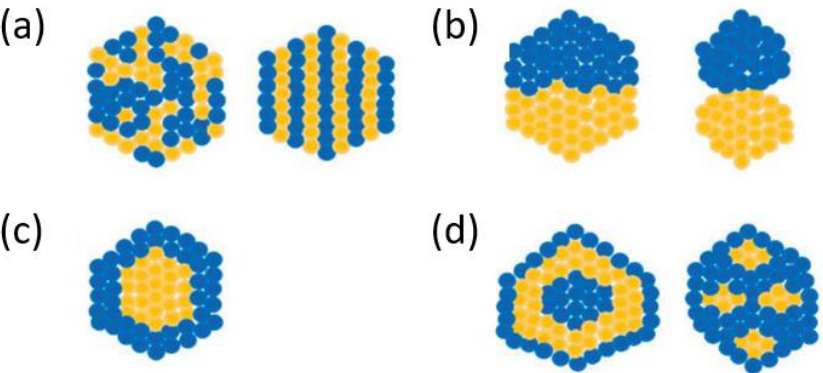
Figure 6. Types of bimetallic alloyed nanoparticles. ( a ) Mixed alloyed nanoparticles; ( b ) sub-cluster segregated alloyed nanoparticles; ( c ) core – shell alloyed nanoparticles; ( d ) multiple core – shell alloyed nanoparticles. Reproduced from [127], MDPI, 2020.